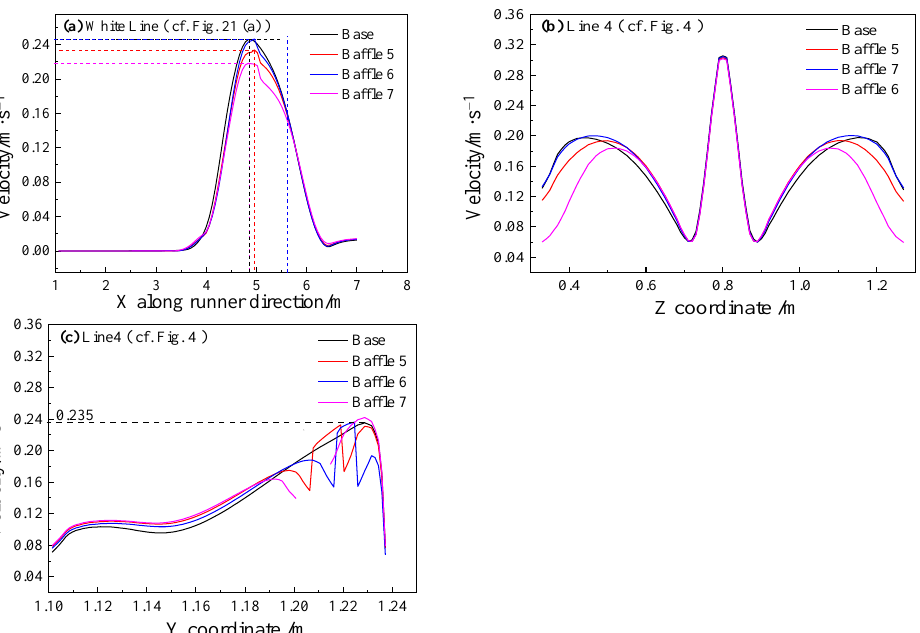
Figure 22. Velocity distribution of different main troughs with different heights near the wall at different lines: ( a ) White Line; ( b ) Line 4; ( c ) Line 4.